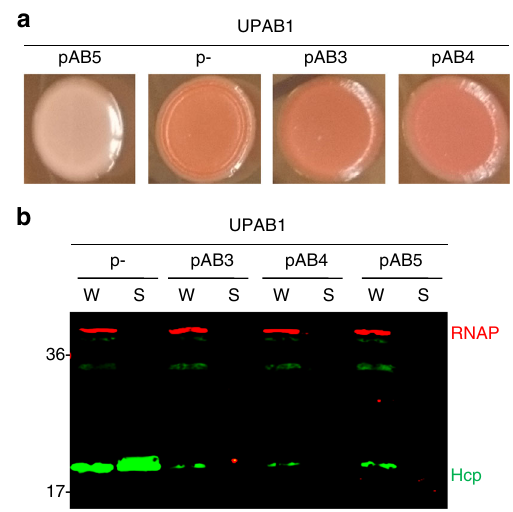
Fig. 8 Effects of different LCPs in UPAB1. a Congo red agar plates, showing differences in the colony color (red versus white) associated with production of PNAG. b Western blot assays probing for Hcp (green) expression and secretion in whole-cell (W) or supernatants (S). RNA polymerase (RNAP, red) was used as a loading and lysis control. Source data are provided as a Source Data fi